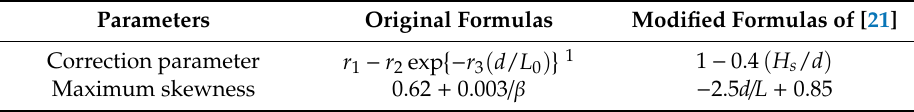
Table 1. Important parameters in the Isobe and Horikawa [1]